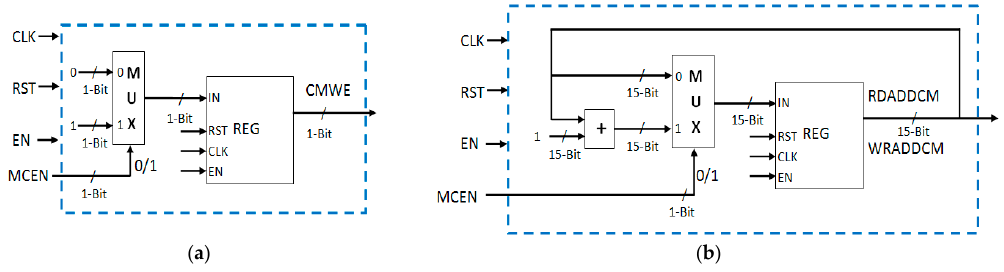
Figure 12. Logic for generating: ( a ) write enable signal; ( b ) addresses for centroid memory.